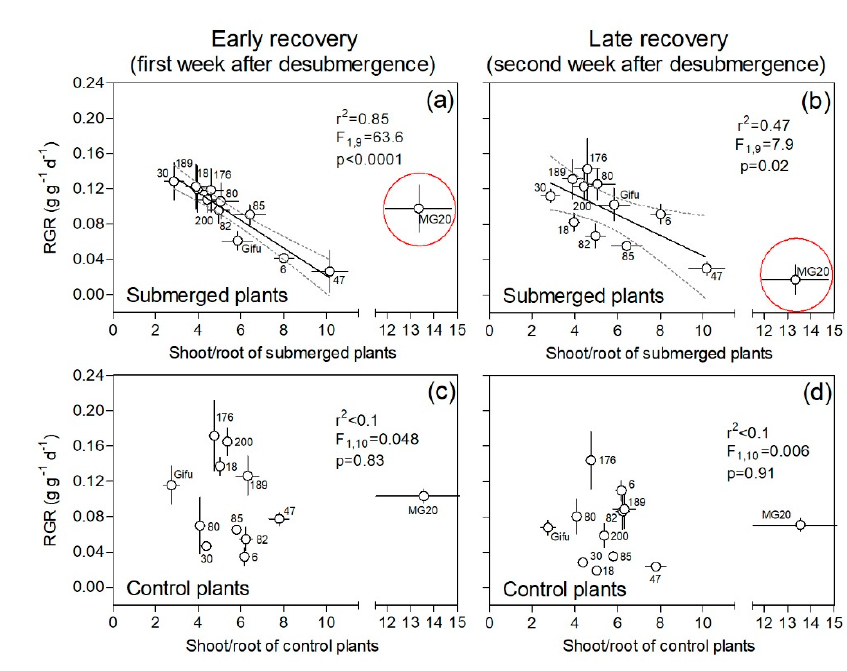
Figure 3. Plant relative growth rate (RGR) during ‘early’ and ‘late’ recovery vs. shoot to root dry mass ratio at the end of the first experimental week for one week of submergence ( a , b ) and control ( c , d ) treatments of 12 genotypes of Lotus japonicus (10 recombinant inbred lines and their parents Gifu and MG20). The first week after de-submergence was used to explore the relationship between these variables in an ‘early recovery’ phase ( a , c ) and the second week in a ‘late recovery’ phase ( b , d ). The MG20 genotype was considered an outlier and was not included in the regression parameters shown in ( a ) and ( b ); however, if included, parameters were r 2 = 0.34, F 1,10 = 5.33, and p = 0.043 and r 2 = 0.63, F 1,10 = 17.50, and p = 0.0019, respectively. Values are means ± standard errors of 6–8